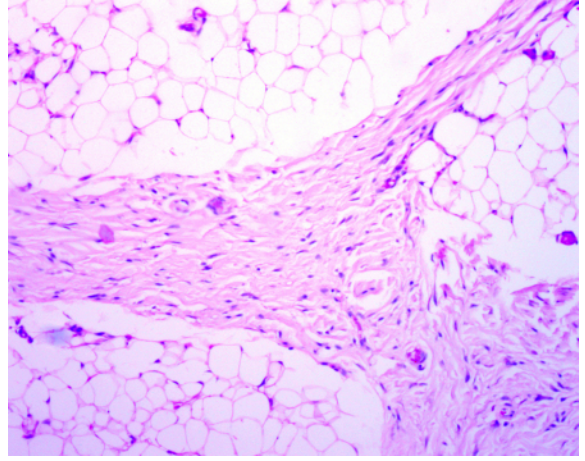
Figure 4: Microscopy showed a lesion composed of mature adipose lobes separated by thick dense connective tissue tracts (H and E,